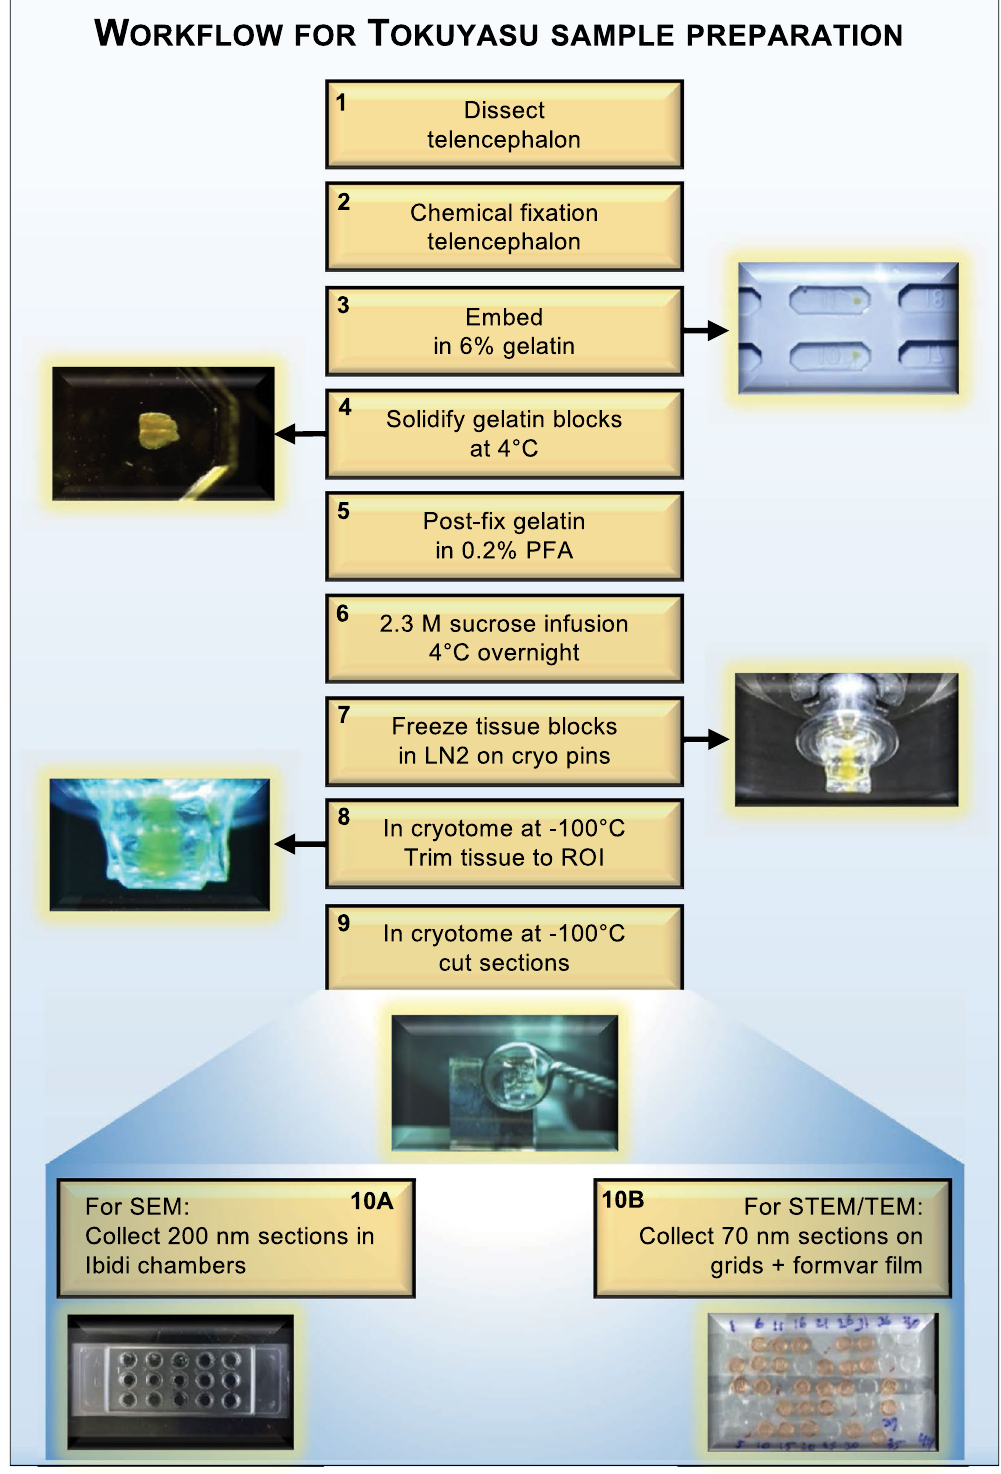
Figure 1. Overview of workflow ( steps 1–10 ) for Tokuyasu sample preparation for subsequent SEM or STEM/ TEM tissue processing. Images highlight examples of key steps in workflow using the adult zebrafish forebrain. Note that step 10A is the endpoint for transitioning to i CLEM-SEM processing, while 10B is the transition point for subsequent i CLEM-STEM/ i CLEM-TEM processing. PFA, paraformaldehyde; ROI, region of